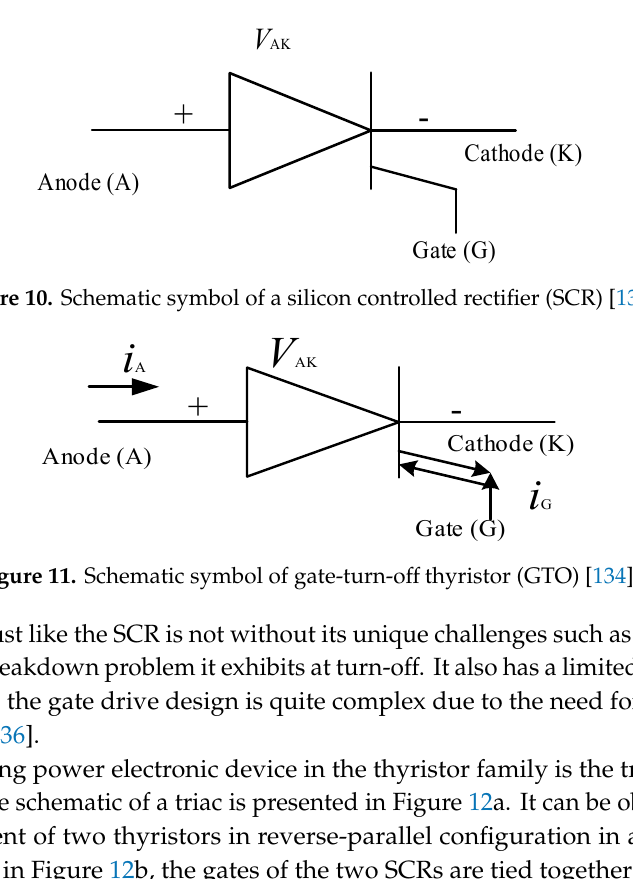
Figure 9. Basic structure of a thyristor [132]. Figure 10. Schematic symbol of a silicon controlled rectifier (SCR) [132].